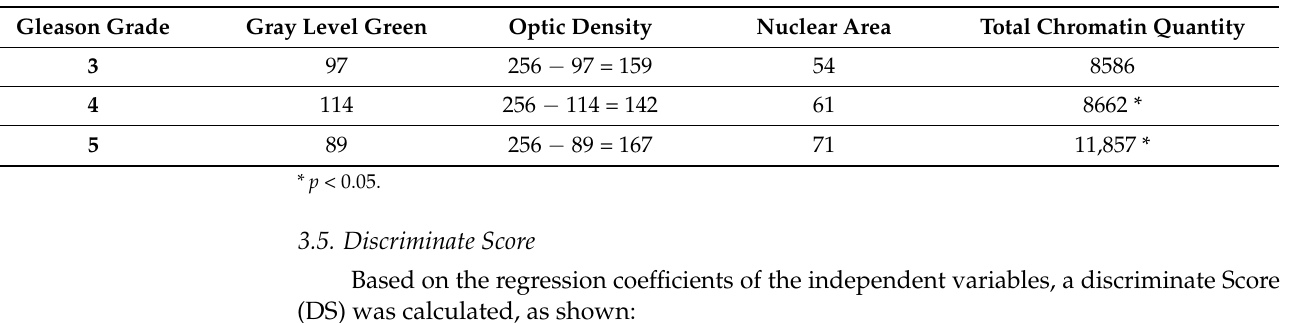
Table 3. Total amount of chromatin quantity depending on the Gleason